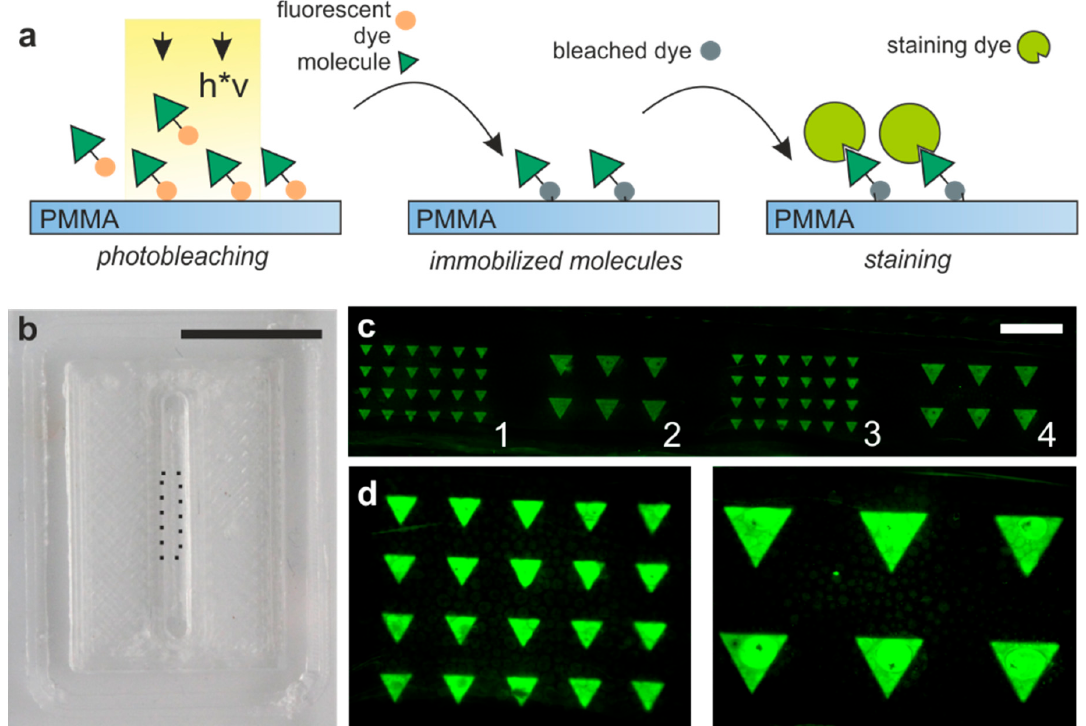
Figure 6. Biofunctionalization inside the 3D printed PMMA channel. ( a ) Fluorescently labelled biomolecules can be covalently bound to surfaces by photobleaching the fluorophore upon exposure with light patterns. ( b ) 2 mm wide embedded PMMA channel printed on a PMMA substrate with biofunctionalization inside the printed channel indicated by dotted lines (scale bar: 10 mm). ( c ) The bottom surface of the 3D printed channel on top of the commercial PMMA slide was functionalized with different biotin patterns by photobleaching of F5B. Patterns were illuminated for 3 min (patterns 1 and 2) and 5 min (patterns 3 and 4). The patterns were visualized via staining with STV-Cy3 (scale bar: 750 µm). Signal-to-noise ratios were calculated for all four images and were on average 29 for 3 min illumination and 11 for 5 min. ( d ) Close-up of patterns which were illuminated for 3 min.